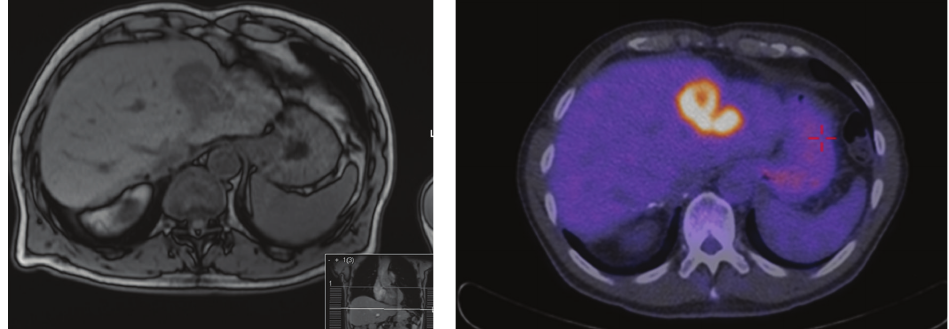
Figure 3: Solitary CRLM following selective interarterial radiation therapy